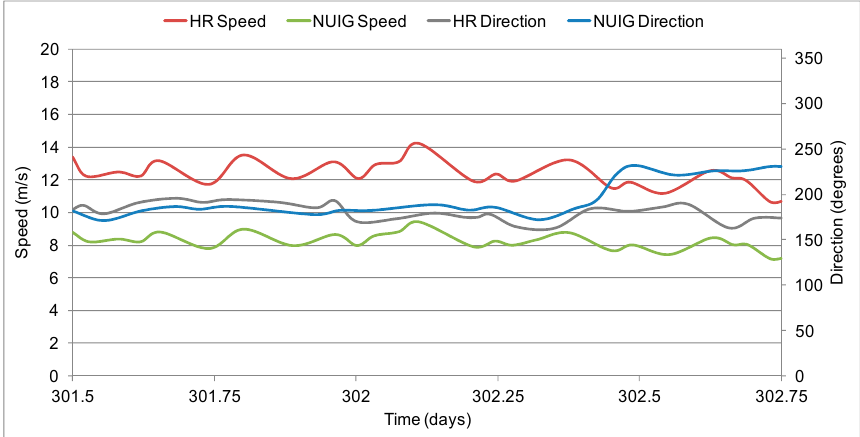
Figure 10. Time series of HR data at A2 against NUIG wind during P2